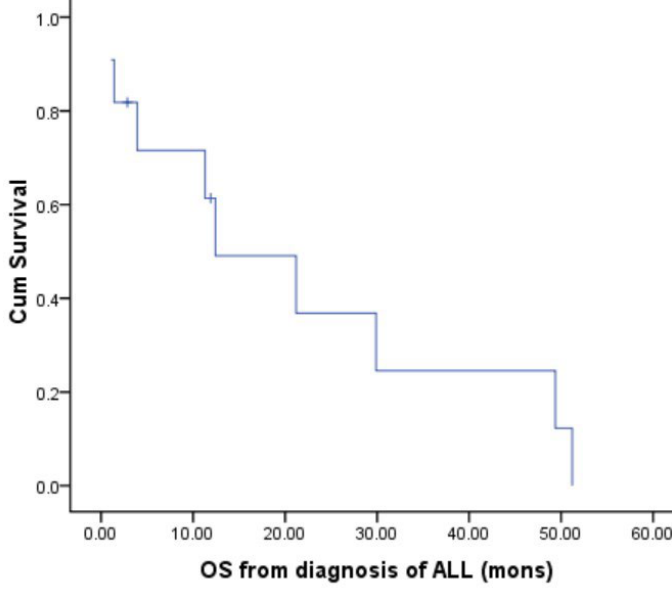
Figure 2. OS from the diagnosis of sALL.